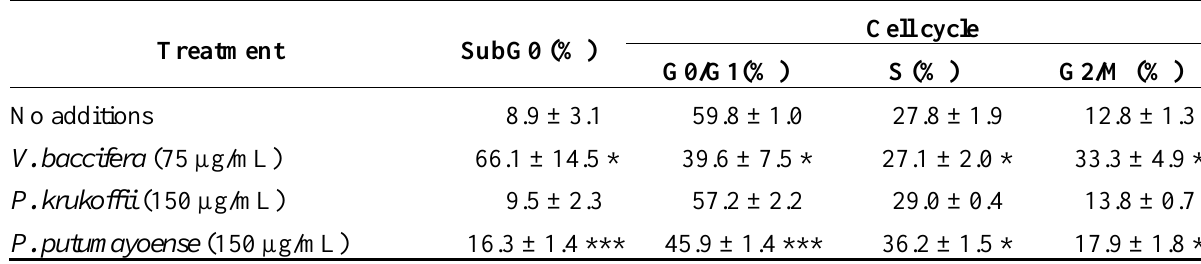
Table 2. Flow cytometry analysis of the effects of plant leaf extracts on rat hepatoma McA-RH7777 cells. Cells in subG 0 were expressed as the percentage of the total cells (SubG0 + G0/G1 + S +